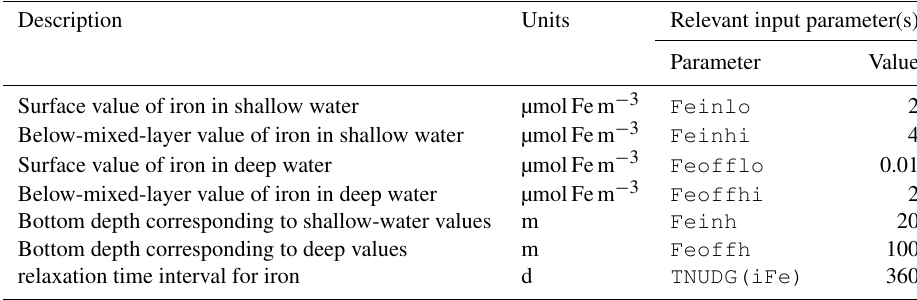
Bottom depth corresponding to shallow-water values Bottom depth corresponding to deep values relaxation time interval for